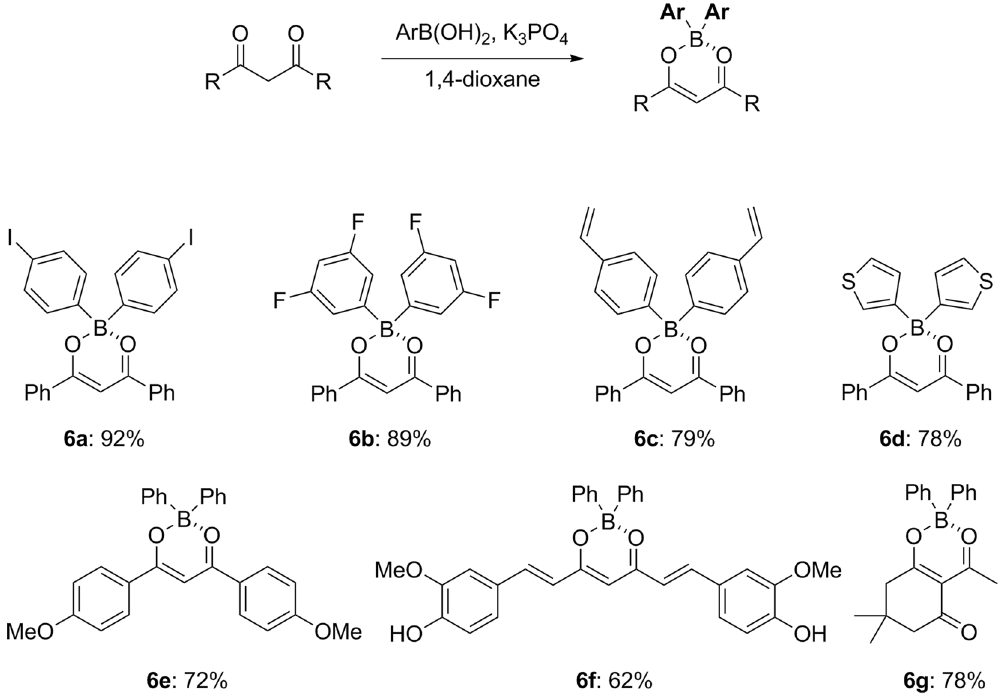
Figure 7. Reaction scope for organoborons from 1,3-diketones. Conditions: 1,3-diketone (1.0 mmol), boronic acid (9.0 equiv), K 3 PO 4 (3.0 equiv) in 1,4-dioxane (0.02 M) at 110 °C with stirring for 20 hours.